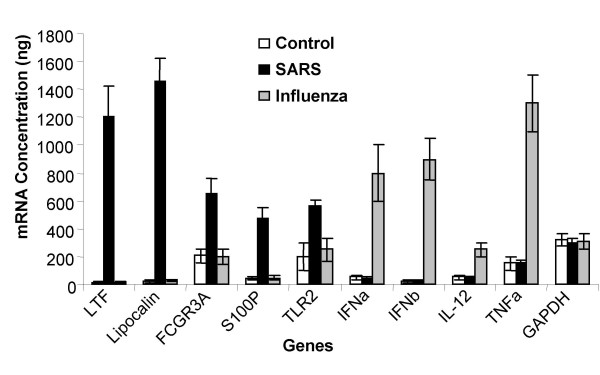
Real-Time PCR of selected genes. PBMCs were isolated from 4 healthy volunteers (Control), from 10 SARS infected patients (SARS), and from 5 influenza virus infected patients (Influenza). Total RNA was extracted from all the samples and Light-Cycler Real-Time PCR was performed. The concentrations of these genes mRNA were calculated using respective standard curves. Lactoferrin expression (LTF); Lipocalin expression (Lipocalin); S100P expression (S100P); FCGR3A expression (FCGR3A); TLR2 expression (TLR2); Interferon Alpha expression (IFNa); Interferon Beta expression (IFNb); Interleukin 12-p40 expression (IL-12); Tumor Necrosis Factor Alpha expression (TNFa); and GAPDH expression (GAPDH). Results are expressed as average ± SD of gene expression for each group (control n = 4; SARS n = 10; and influenza n = 5).